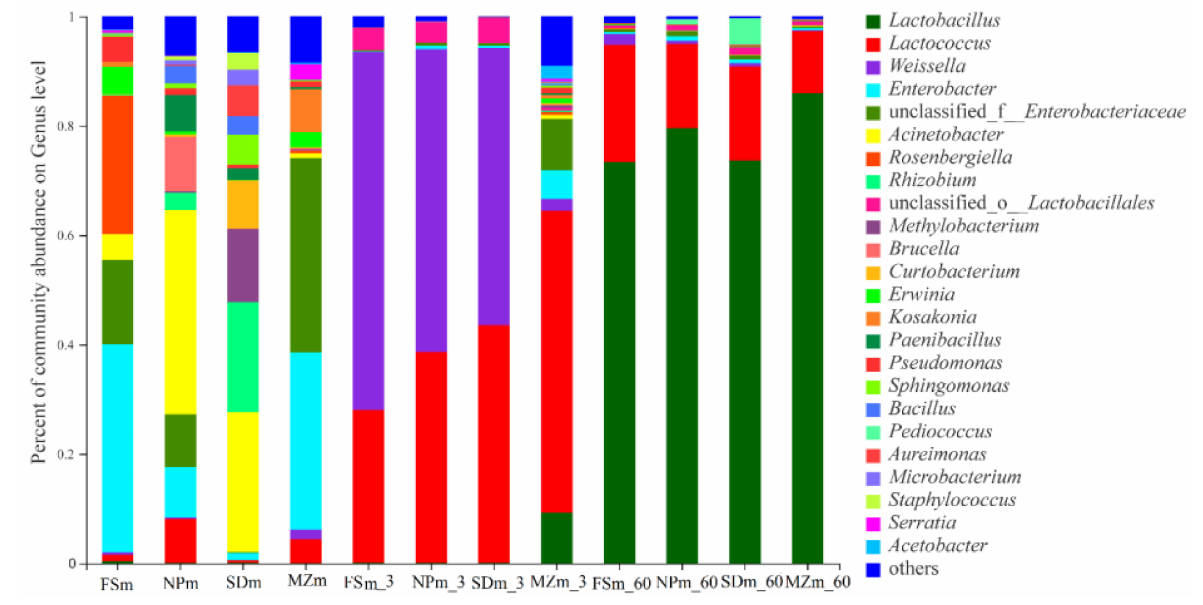
Figure 3. Relative abundance of bacterial community at the genus level in forage sorghum silage. FSm, forage sorghum microbiota; NPm, Napier grass microbiota; SDm, Sudan grass microbiota; MZm, maize microbiota; 3, 3 days of ensiling; 60, 60 days of ensiling.